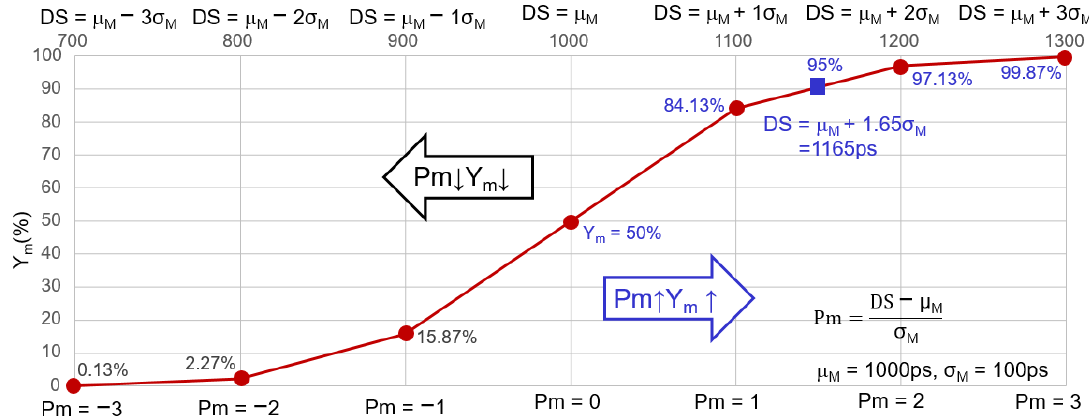
Figure 2. Product manufacturability impact on manufacturing yield.